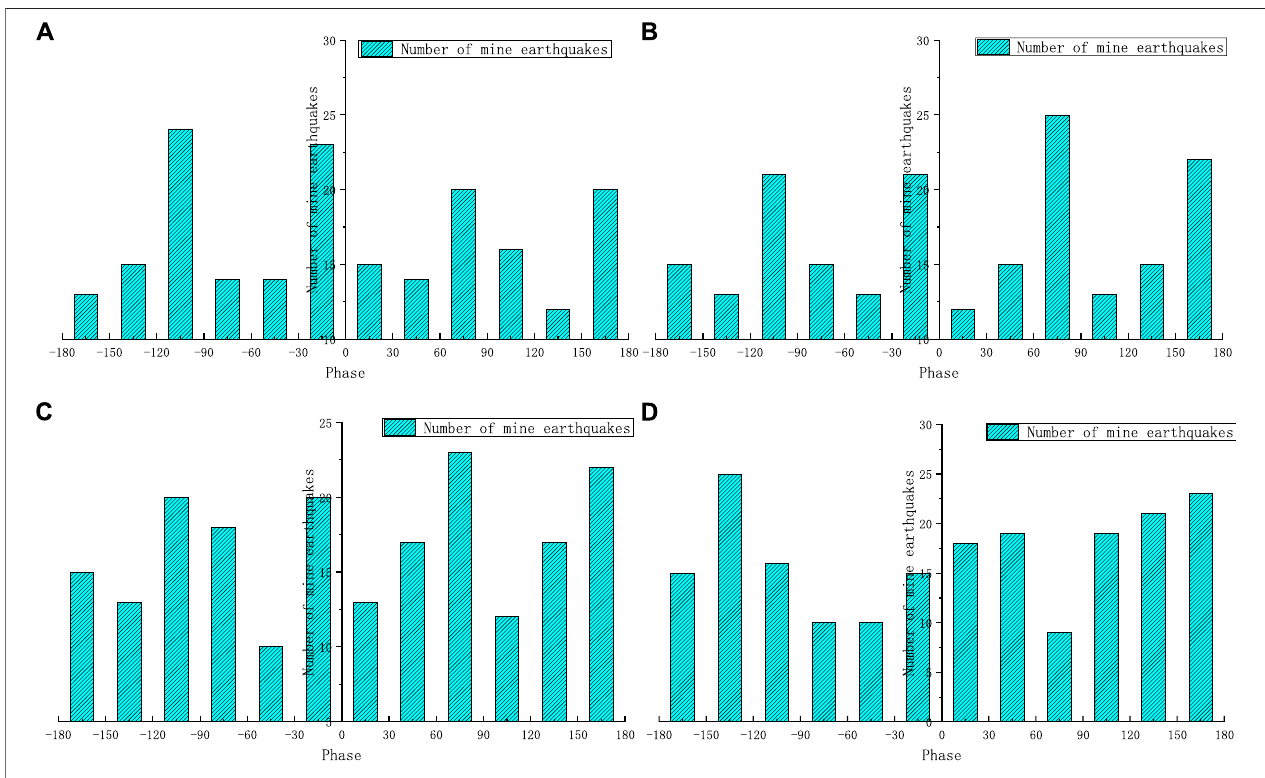
FIGURE 4 | Statistical histogram of the mine earthquake M L < 0